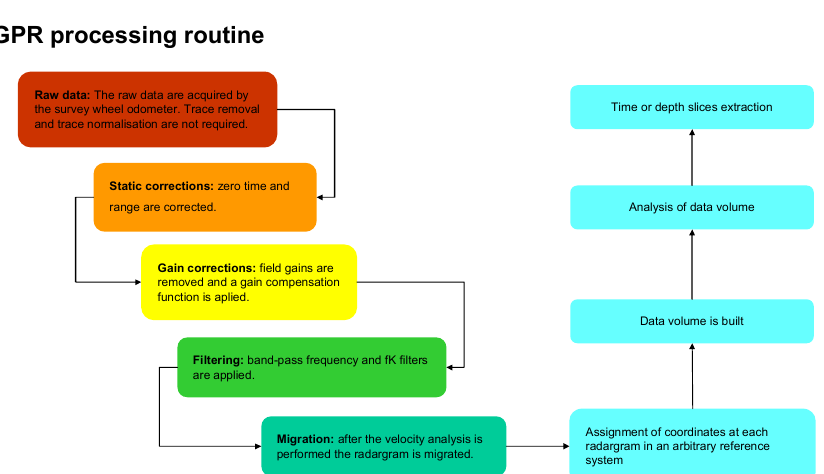
Fig. 4. Example of GPR data processing needed to obtain time or depth